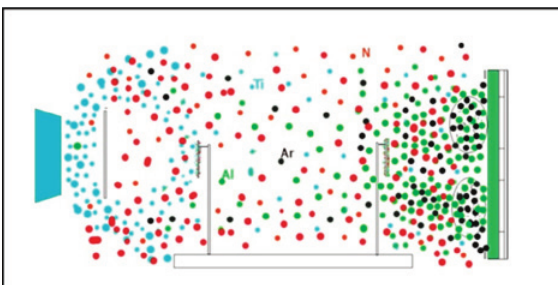
fig. 9. Schematic diagram of the preparation of the nitride